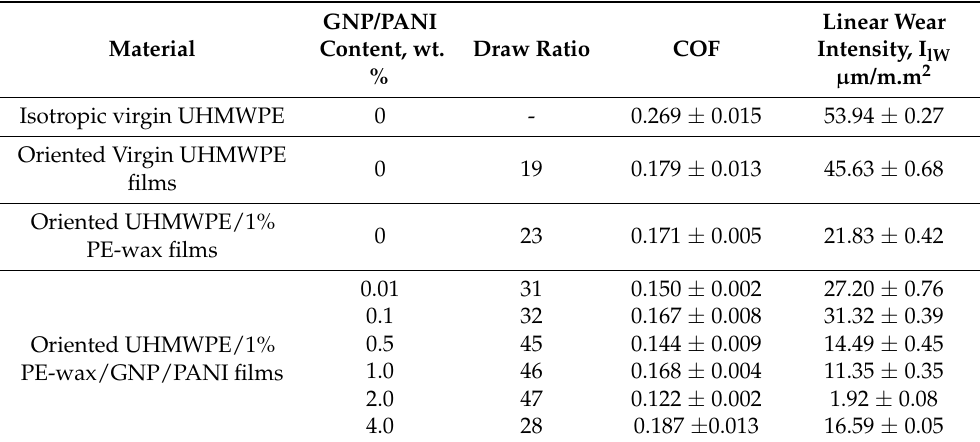
Table 7. Tribological properties of isotropic UHMWPE, virgin-oriented UHMWPE film, oriented UHMWPE/1.0% PE-wax films, and oriented UHMWPE/1.0% PE-wax/GNP/PANI films obtained by first thermal orientation regime ( ± the standard